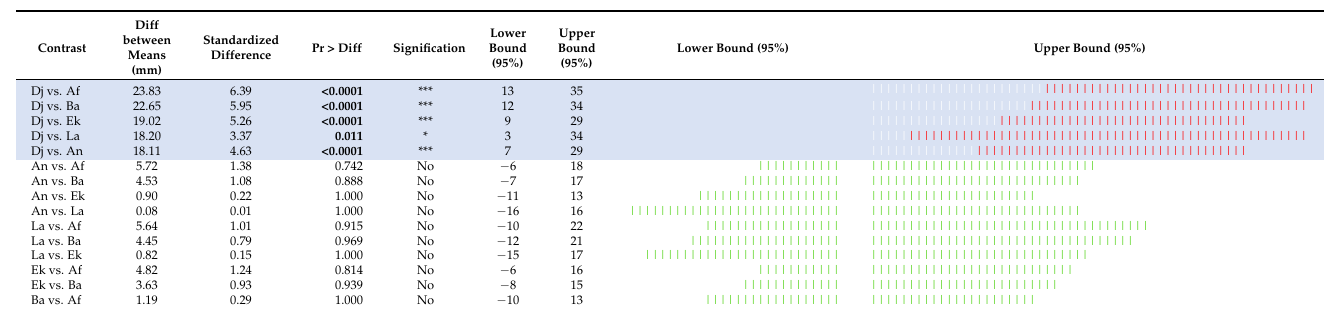
Table 3. Tukey Post hoc test (HSD) of straight carapace length (SCL) between localities at 95% confidence interval. Ek—El Kala; An—Annaba; Ba—Batna; Dj—Djelfa; La—Laghouat; Af—Aflou. Signification: * = p < 0.05, ** = p < 0.01, *** = p <